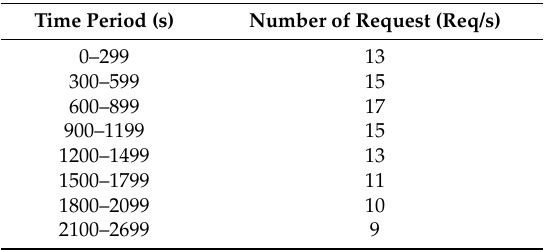
Table 1. Setting of the processing load of the test bed system.